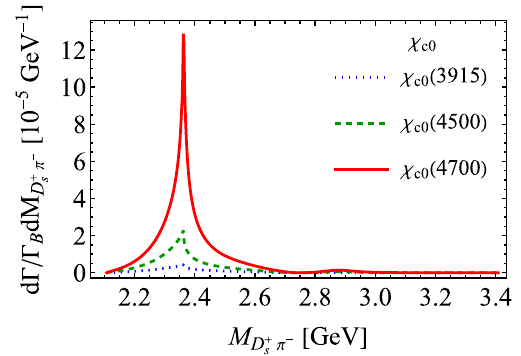
Fig. 5 Invariant mass distributions of D + s π − via the rescatterings in Fig.1cwithouttakingintoaccounttheinterferencewiththebackground. The masses and widths of different χ c 0 listed in Eq. (20) are adopted